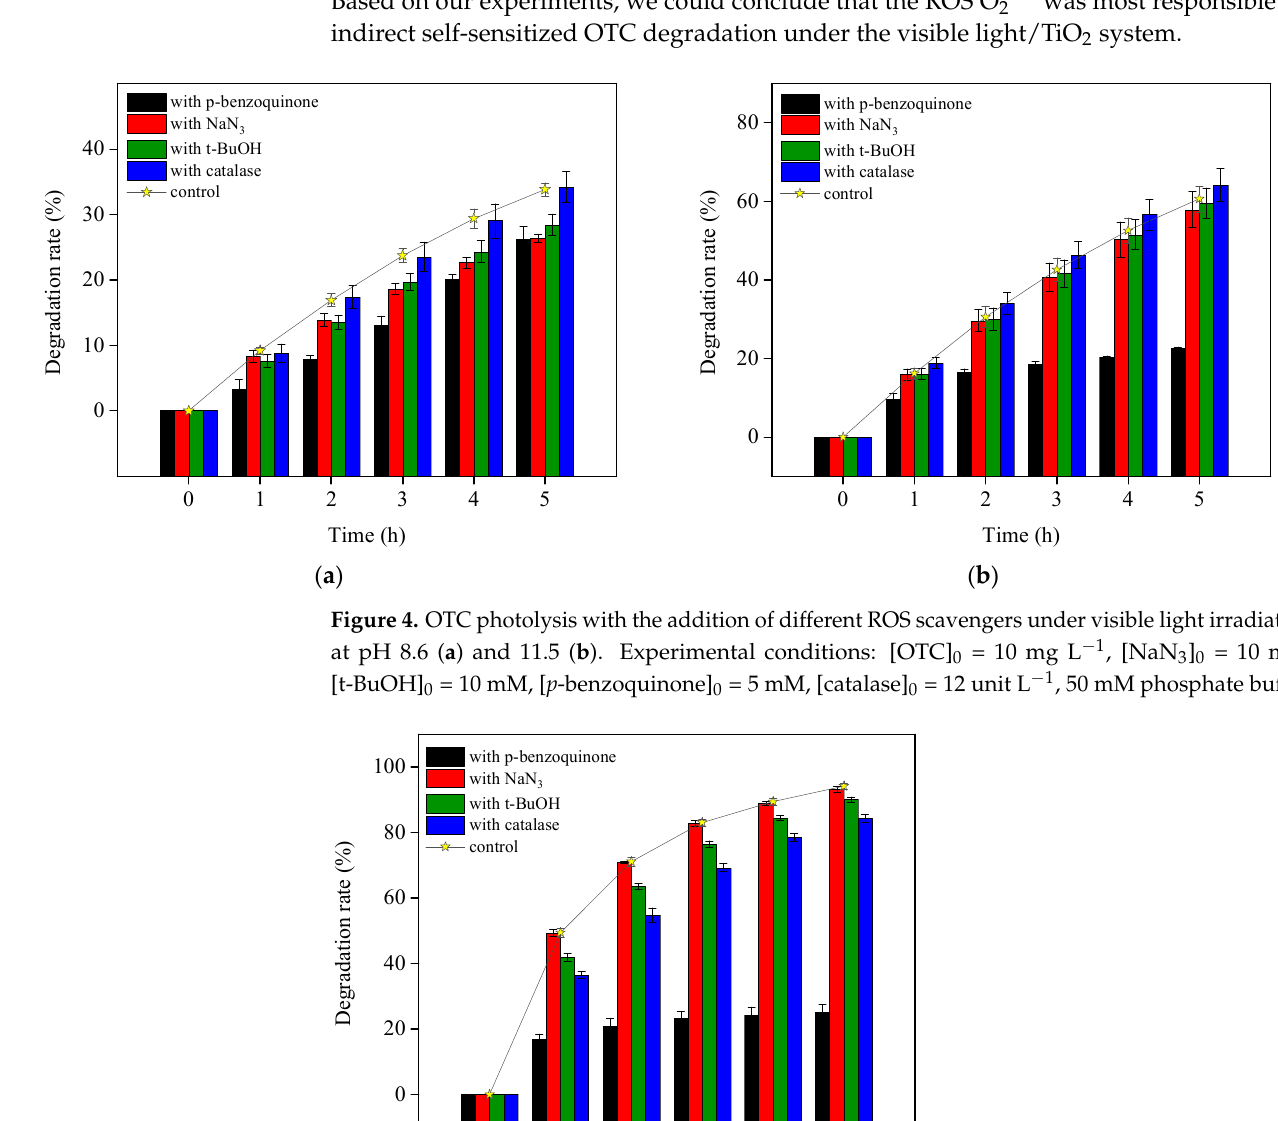
Figure 4. OTC photolysis with the addition of different ROS scavengers under visible light irradia- tion at pH 8.6 ( a ) and 11.5 ( b ). Experimental conditions: [OTC] 0 = 10 mg L − 1 , [NaN 3 ] 0 = 10 mM, [t- BuOH] 0 = 10 mM, [ p -benzoquinone] 0 = 5 mM, [catalase] 0 = 12 unit L − 1 , 50 mM phosphate buffer.